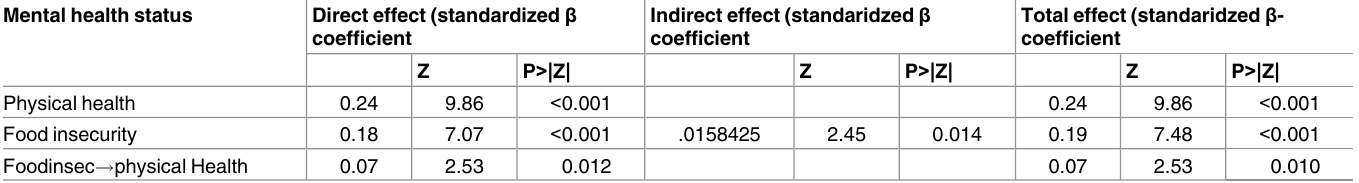
Table 4. Estimation of direct, indirect and total effect of food insecurity on youth common mental disorders, JLFSY, Southwest Ethiopia 2015. Mental health status Direct effect (standardized β